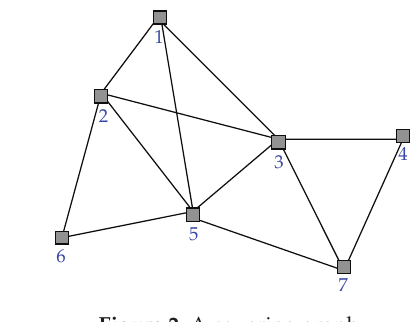
Figure 2: A covering graph.